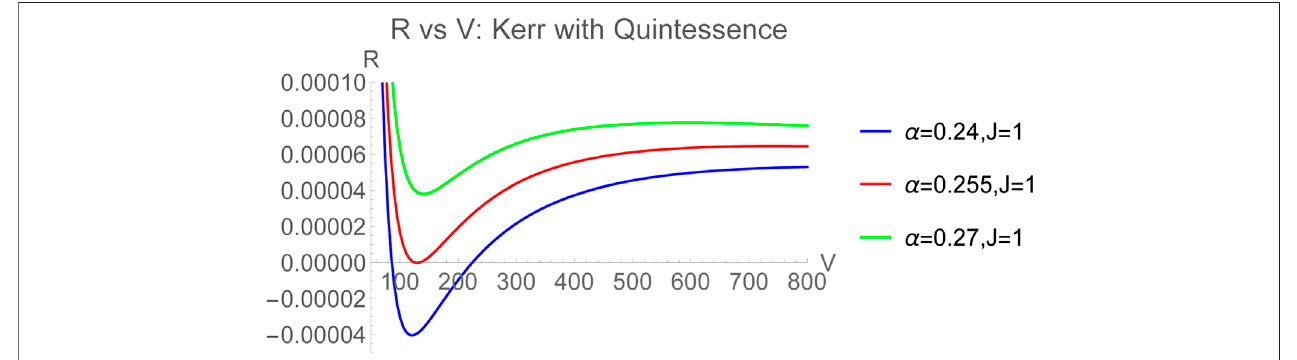
FIGURE 6 | Ruppeiner curvature for Kerr-AdS black hole surrounded by quintessence on the ( T , V ) -plane as a function of V for fi xed T and angular momentum J